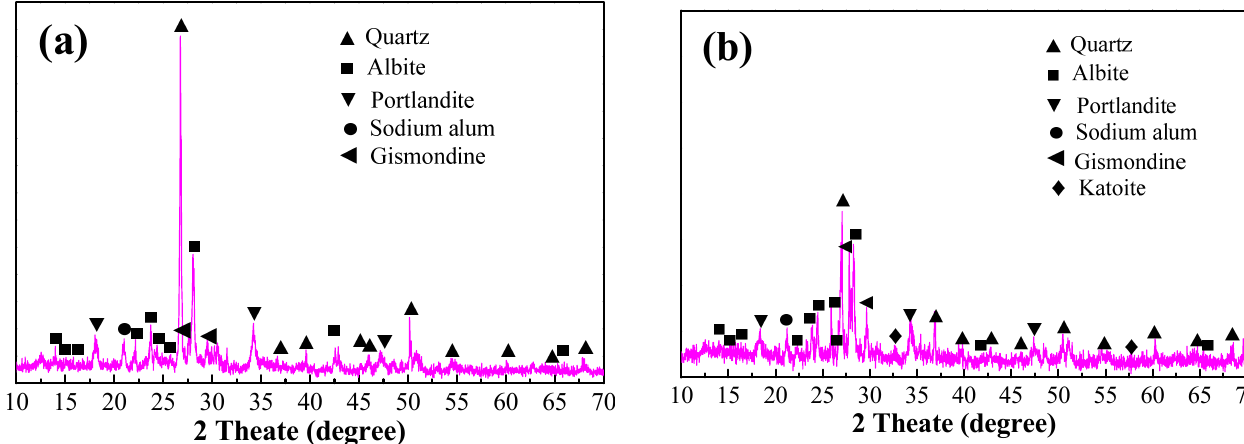
Figure 11. The XRD patterns of ( a ) rock powder mixed with lime and ( b ) the rock powder-lime products on the surface of the FAC particles.